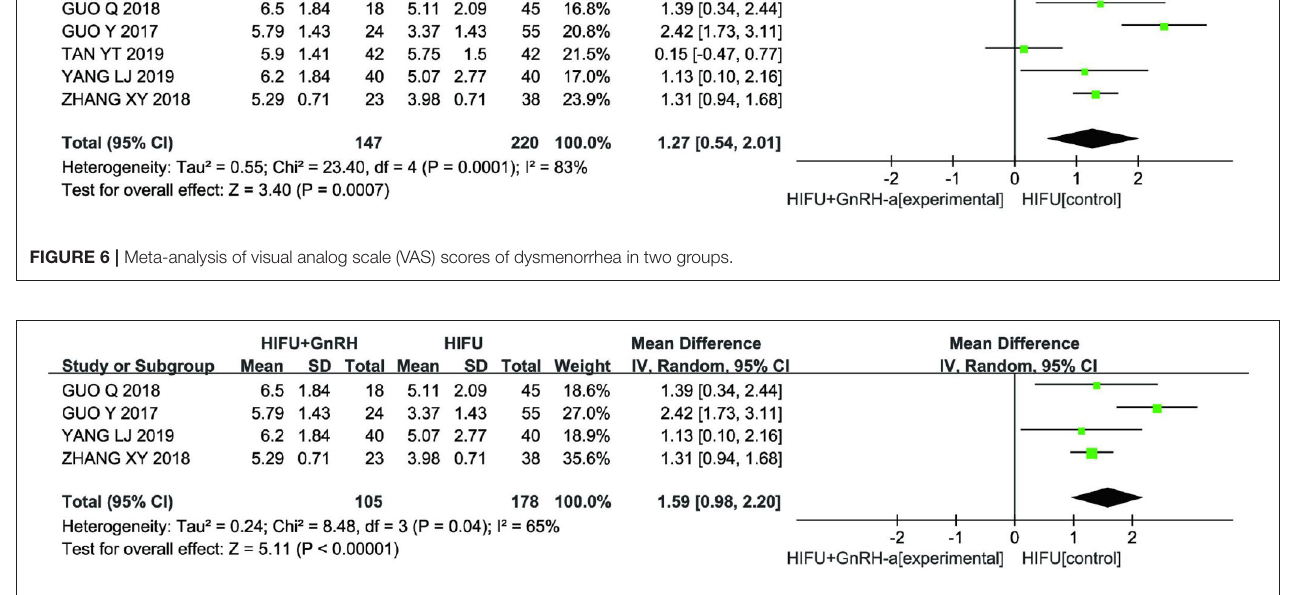
FIGURE 7 | Sensitivity analysis of visual analog scale (VAS) scores of dysmenorrhea in two groups.